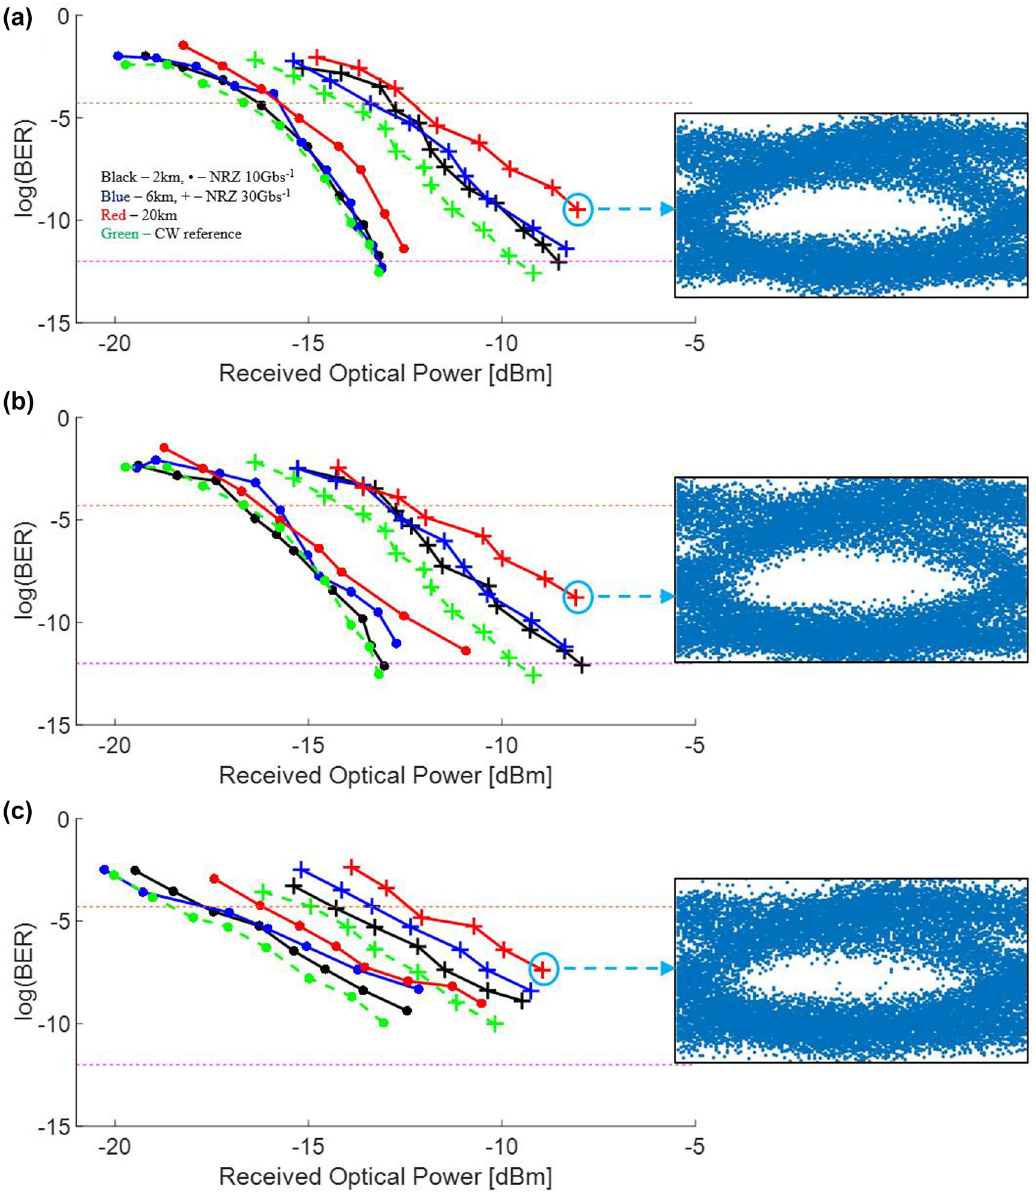
Figure 5: High-speed data experimental characterization using NRZ data, showing BER less than the FEC threshold and open eye diagrams for all comb lines. 10 Gb s − 1 ( ∙ ) and 30 Gb s − 1 ( + ) NRZ data are modulated onto the frequency combs lines prior to transmission through 2 km (black), 6 km (blue) and 20 km (red) optical fiber. Measured bit error rate for the comb lines at (a) 1542 nm (Comb1), (b) 1564 nm (Comb2) and (c) 1575 nm (Comb3). The CW reference is shown in green for both 10 Gb s − 1 and 30 Gb s − 1 NRZ data. The orange and Fuchsia dotted lines denote the FEC BER limit of 5 × 10 − 5 and error free BER limit of 10 − 12 respectively. Bit error rates ≈ 10 − 12 well below the FEC threshold is achieved for all fiber lengths and data rates tested for Comb1 (1542 nm) and Comb2 (1564 nm). Eye diagrams for 30 Gb s − 1 NRZ data after transmission through 20 km of optical fiber are also shown for each comb